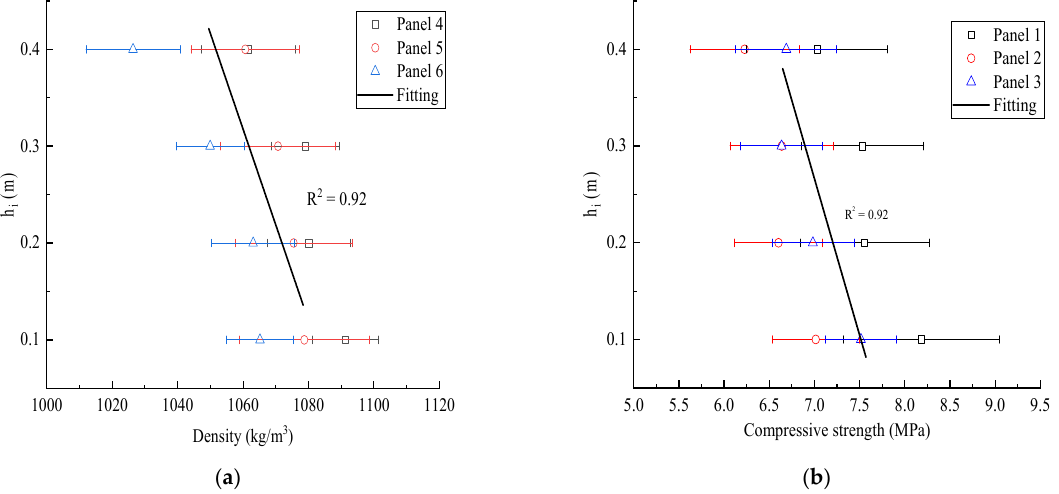
Figure 10. Graphs of parameter variation with height: ( a ) variation trend of density with height; ( b ) variation trend of compressive strength with height.